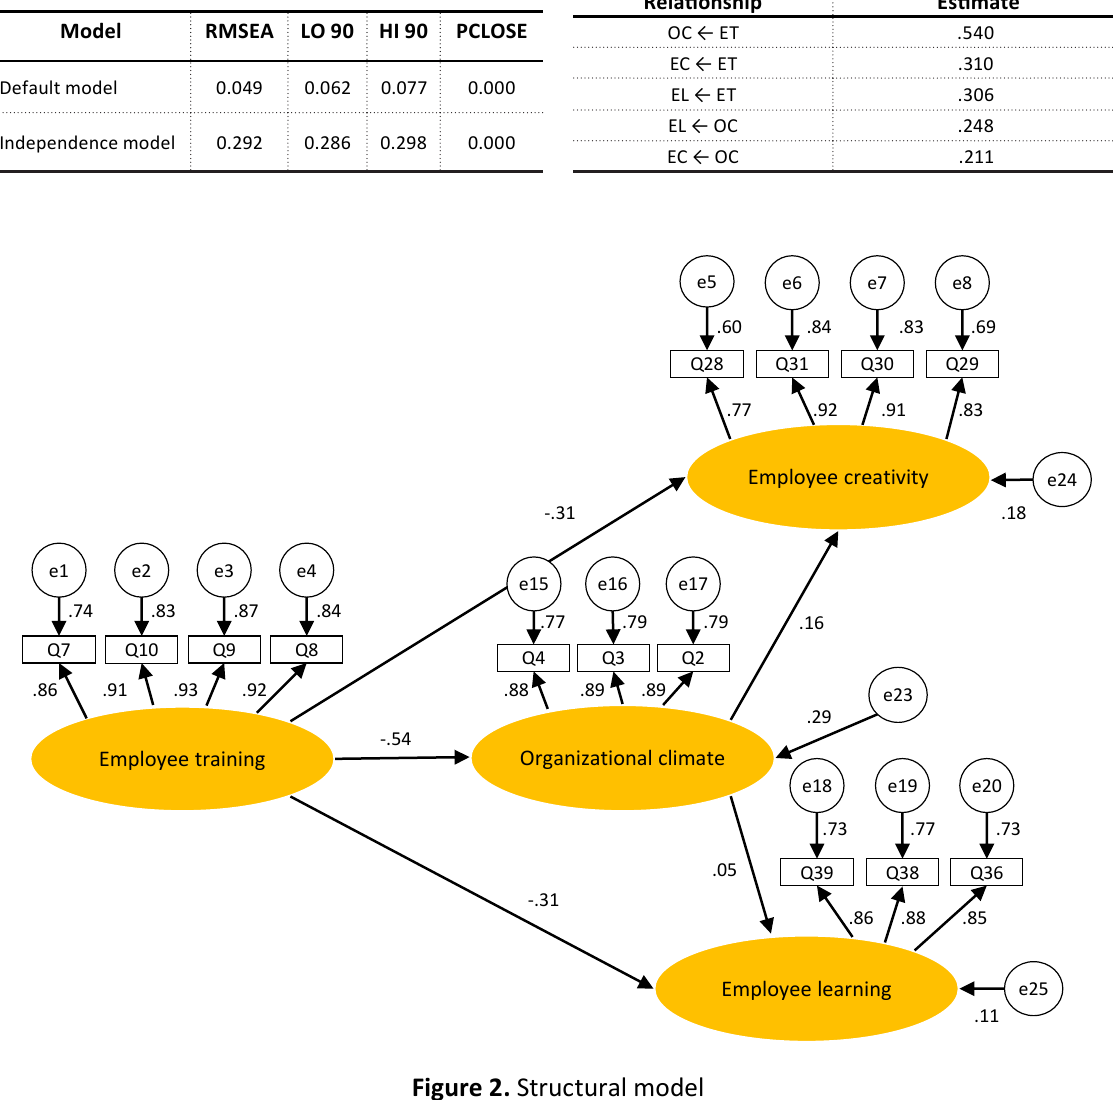
Figure 2. Structural